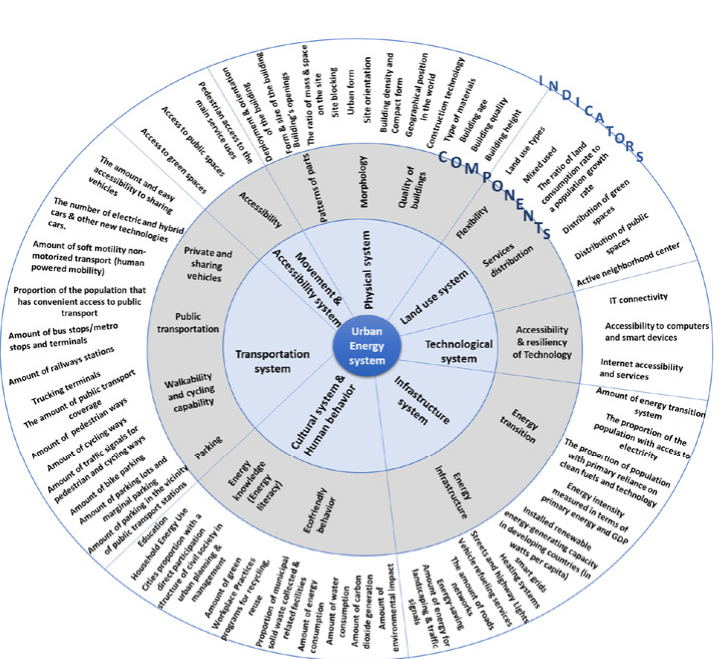
Fig. 2: Conceptual framework of the Urban Energy System (UES)